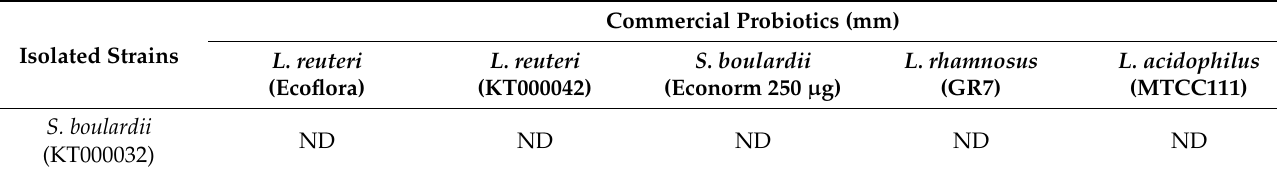
Table 9. Commensal efficiency (disc diffusion method, mm) of CFS of S. boulardii strains against commercial probiotics and clinical pathogens.